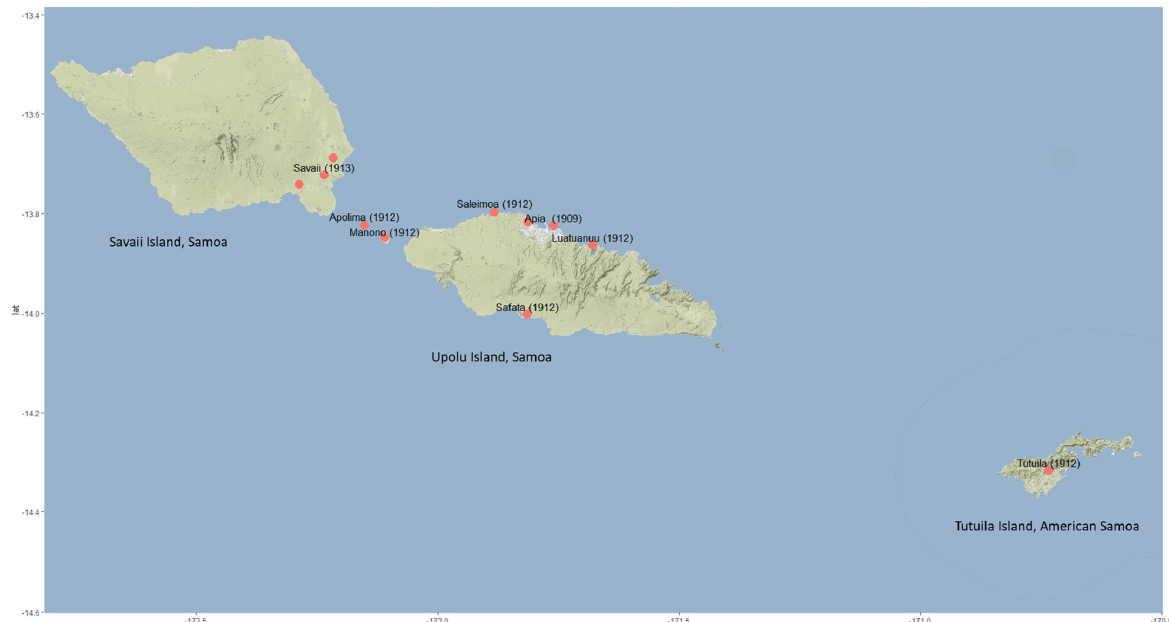
Figure 3. Spread of CRB ( Oryctes rhinoceros ) within the Samoan islands after its first confirmation in Apia, Samoa 1910. Longitude values are shown on the x-axis and the latitude values on the y-axis.